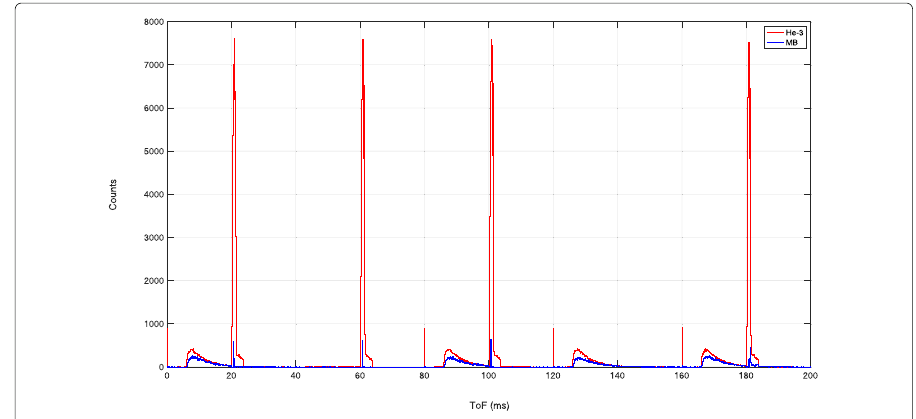
Fig. 15 ToF spectrum obtained with the Multi-Blade detector (blue line) and the 3 He-tube (red line) in a time window of 200